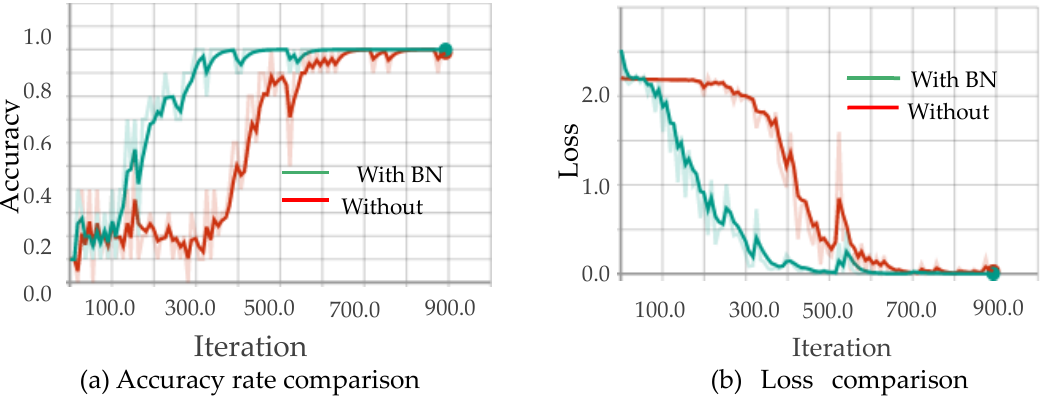
Figure 10. Comparison curves for the RGB image.